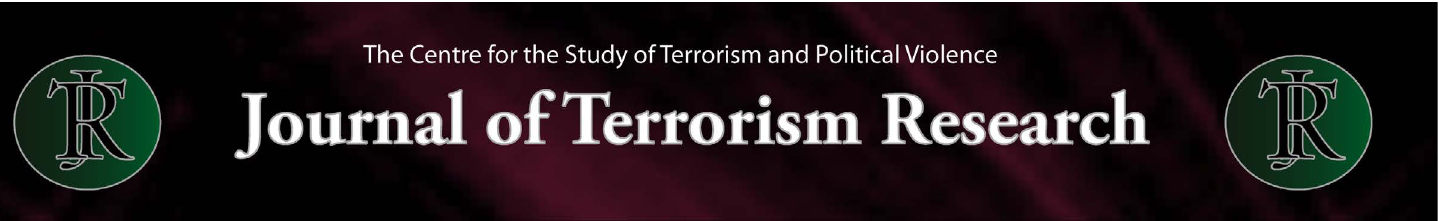
Table 1: Variables of the Study Variable Description Source Design Code Frequency of incidents (INC) DV Count GTD Database